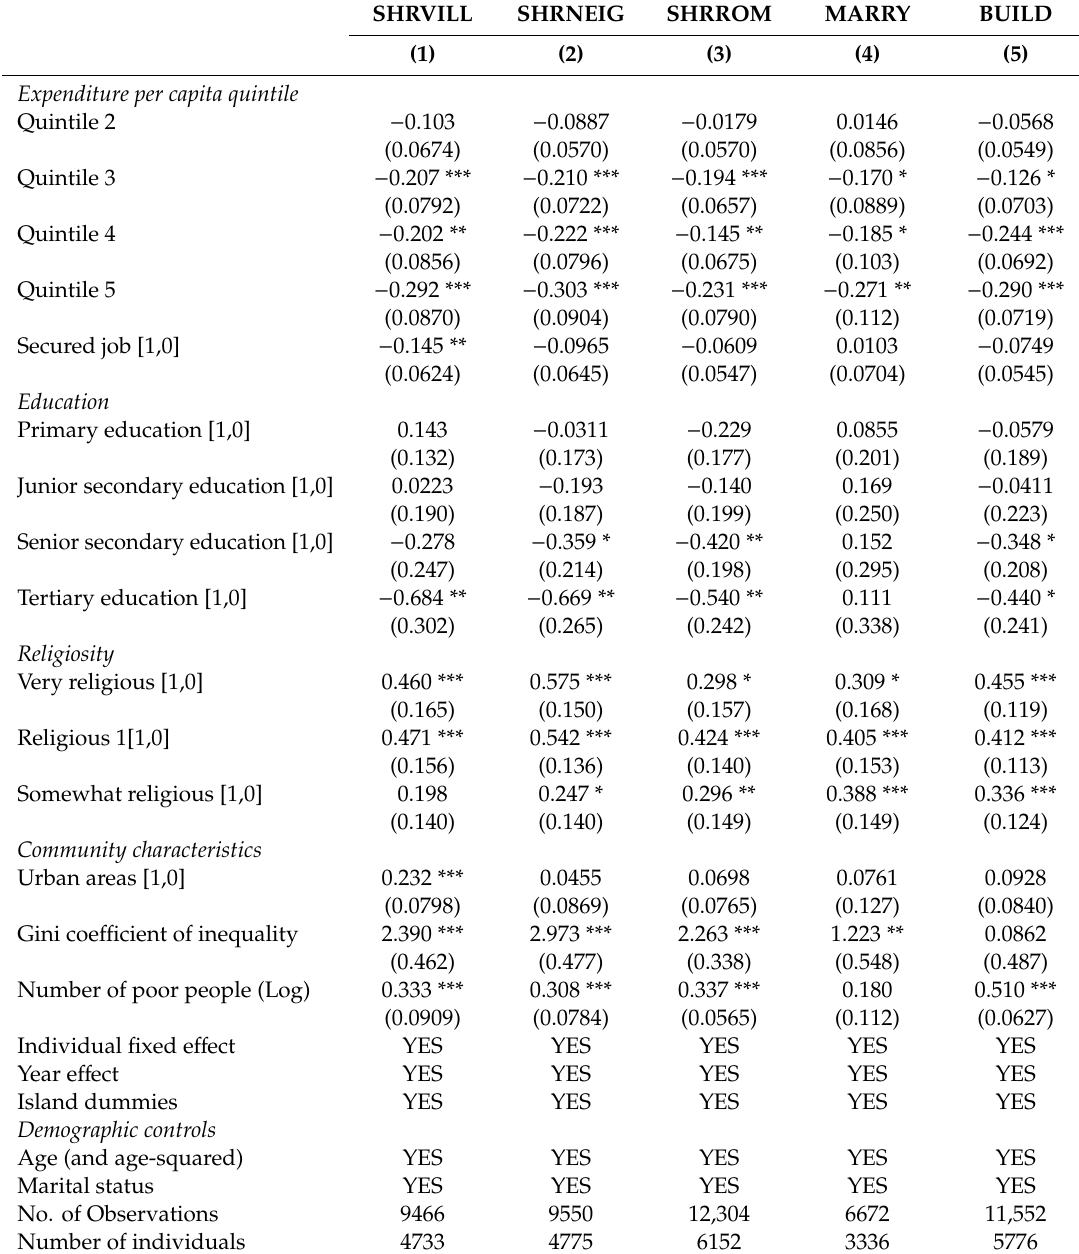
Table 4. Regression results (Fixed-e ff ect conditional logit Model) with quintile of expenditure per capita as a measure of